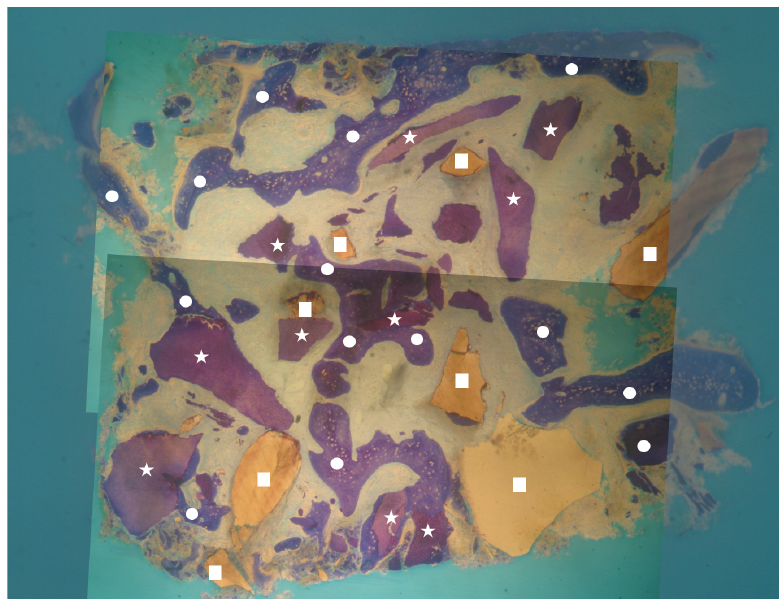
Figure 1. Overview of a biopsy at low magnification. Group 1: dentin matrix granules (indicated by white stars) originating from whole tooth completely surrounded by newly formed bone (indicated by white circles) are visible. No inflammatory or other adverse reaction is visible around the particles (magnification 8×; toluidine blue).